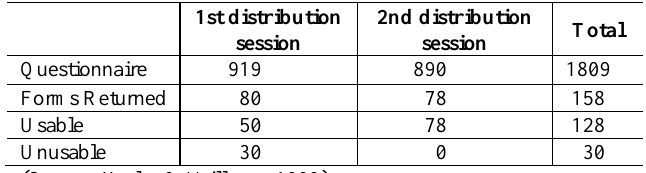
Table 1: Questionnaire response